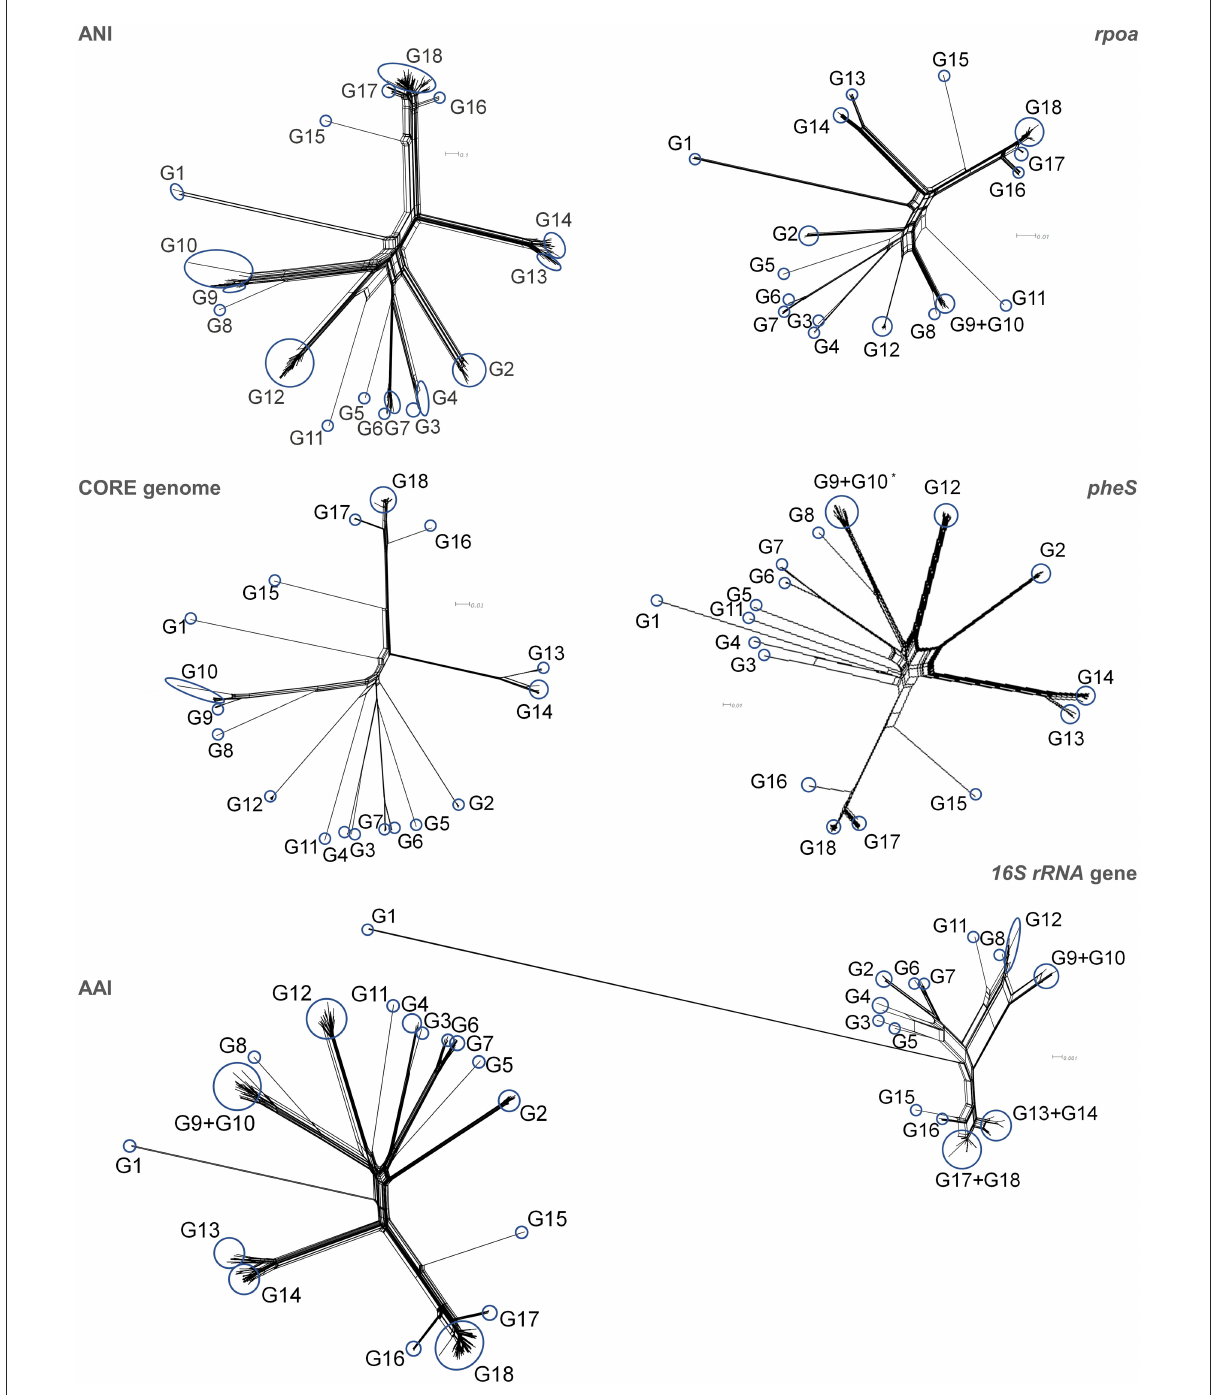
FIGURE3 Split decomposition analysis of the phylogenetic trees of ANI, core genome, AAI, rpoA , pheS, and 16S rRNA genes. The analysis was performed utilizing gene alignments for the core genome, rpoA , pheS, and 16S rRNA genes, and distance matrix for ANI. Blue circles indicate the position of groups on split-decomposed trees. * For clarity of representation, the strain L. lactis AV1N that harbored a highly divergent pheS sequence, was not included.